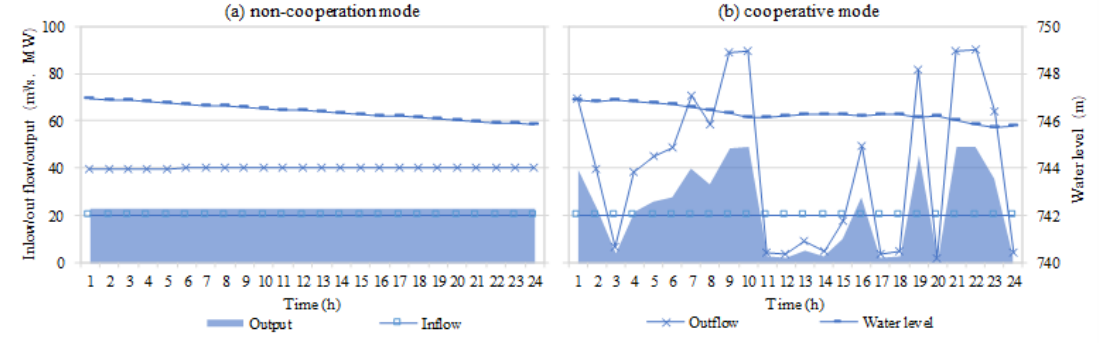
Figure 10. Operation process of SHP1 in County 1.